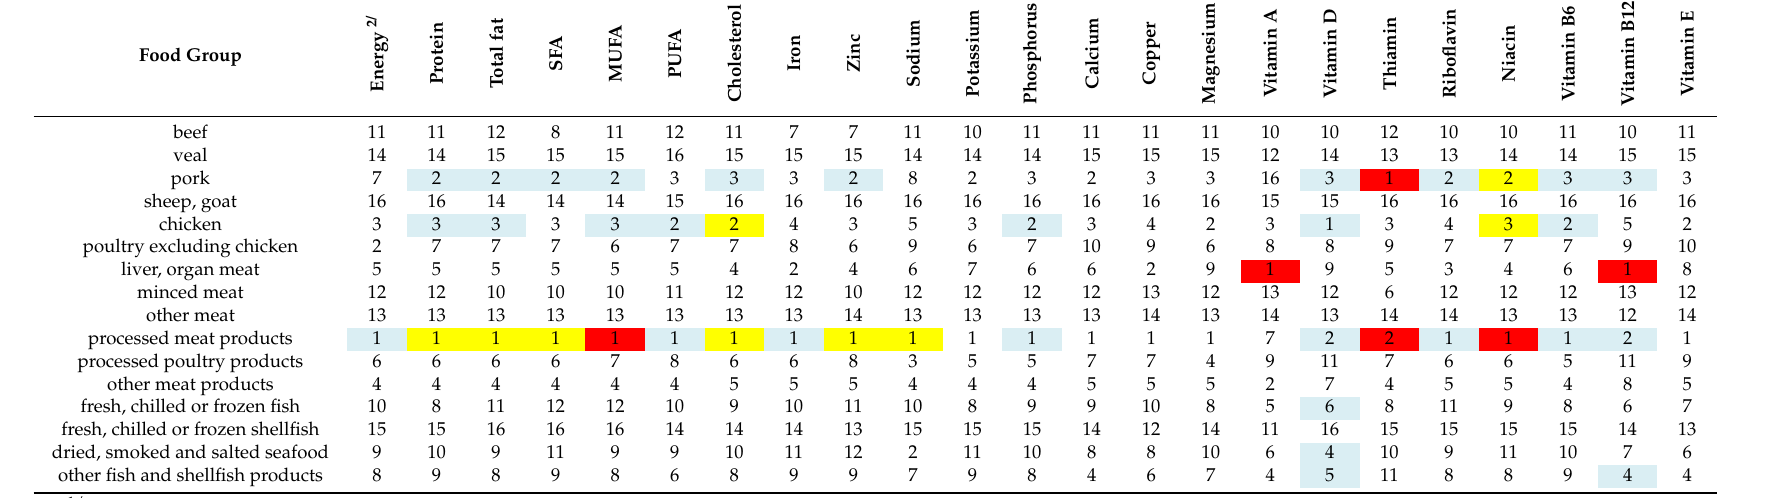
Table 10. Summary: Rankings of food products as contributors of energy and nutrients 1/ in the average Polish